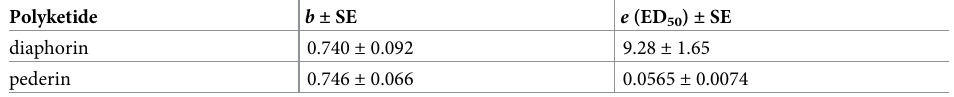
Table 1. Coefficients of the model fitted to the polyketide dose–Sf9 cell survival curves.